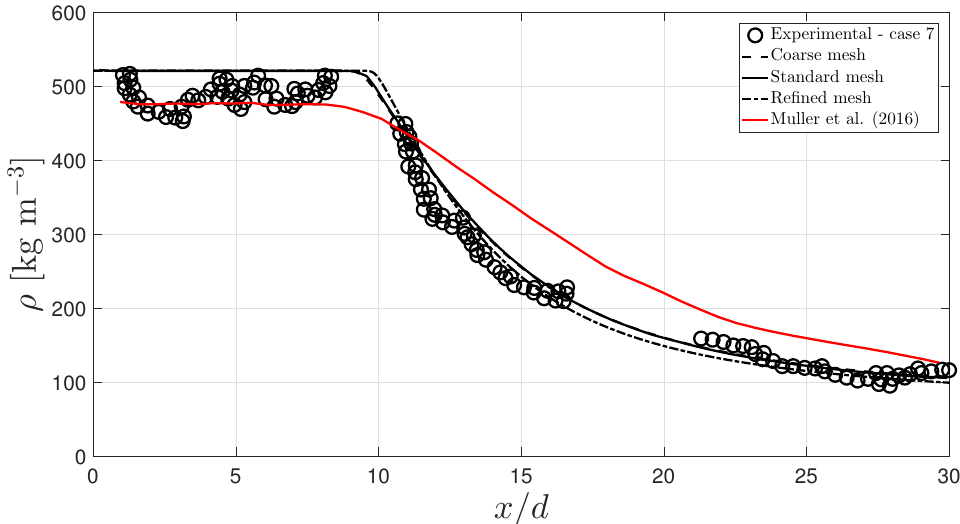
Figure 8. Axial density distribution for case 7 and comparison with experimental data and the computations of Müller et al. [61].